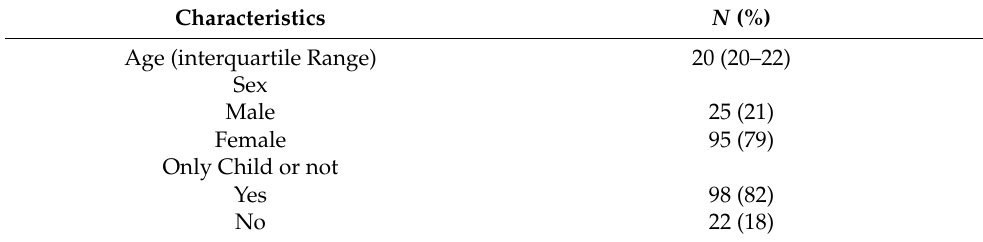
Table 1. Characteristics of Participants ( N =